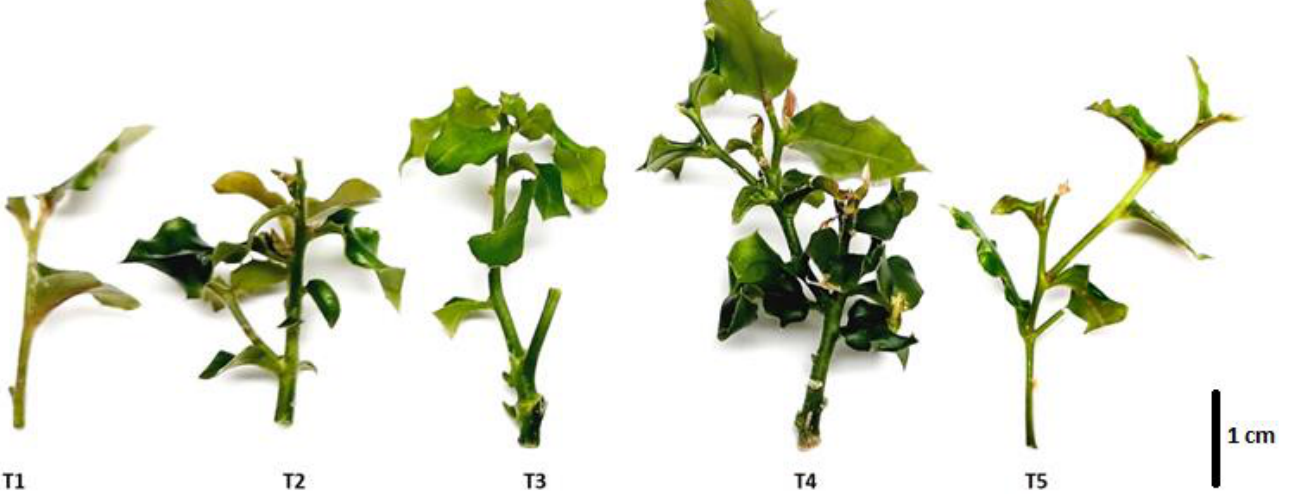
Figure 1. Representative shoots of C. mucronata at the in vitro multiplication stage under different experimental treatments. T1: Control; T2: 1.78 μM BAP; T3: 3.55 μM BAP; T4: 4.44 μM BAP; T5: 11.10 μM BAP. Scale bar 1